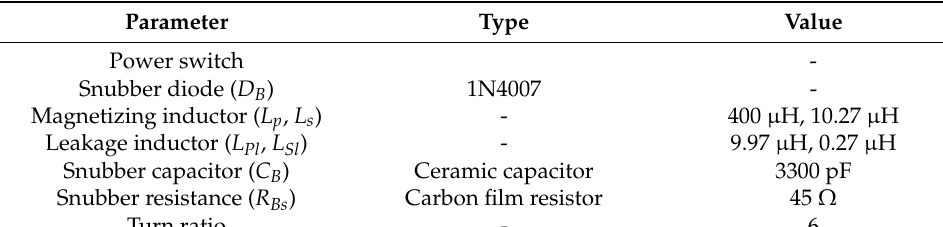
Table 10. Parameter of the proposed converter.